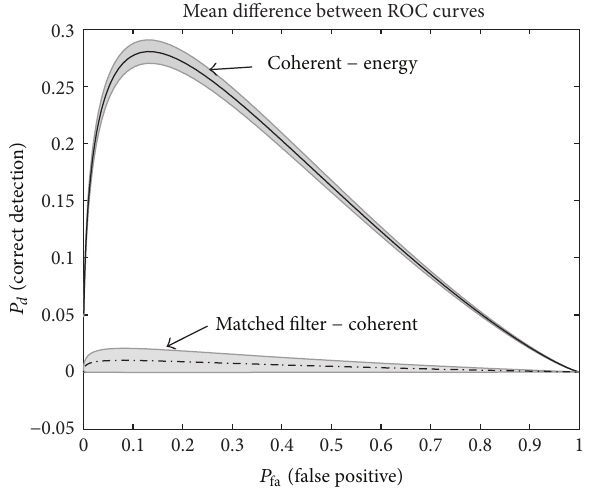
Figure 9: ROC curve for the matched filter detection, energy detector, and the coherent detector for different levels of SNR in the incident field. For all cases the SNR of the scattered field was kept fixed at 0.2, and the number of receivers was kept at